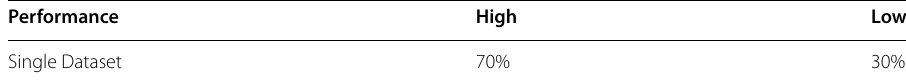
Table 5 Performance of the single dataset Performance